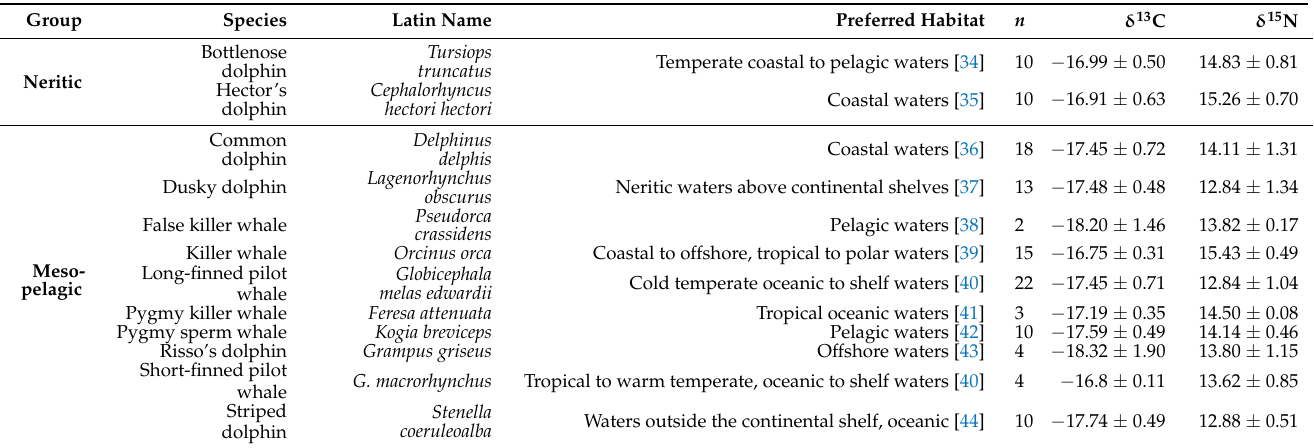
Figure 1. Locations for 21 species of cetaceans (denoted by shape and colour) sampled in New Zealand between 2010 and 2021. Sample size for each species is denoted in parentheses. Bathymetry is depicted with darker shades of blue representing deeper waters (data from the National Institute of Water and Atmospheric Research (NIWA) under a CC BY license, with permission from NIWA original copyright [33]). Table 1. Suess-corrected carbon ( δ 13 C) and nitrogen ( δ 15 N) isotope values and sample sizes ( n ) for independent odontocete species sampled in Aotearoa, New Zealand, 2010–2021. Values are given as mean ± 1 SD. See Figure 2 for an illustration of habitat zones.